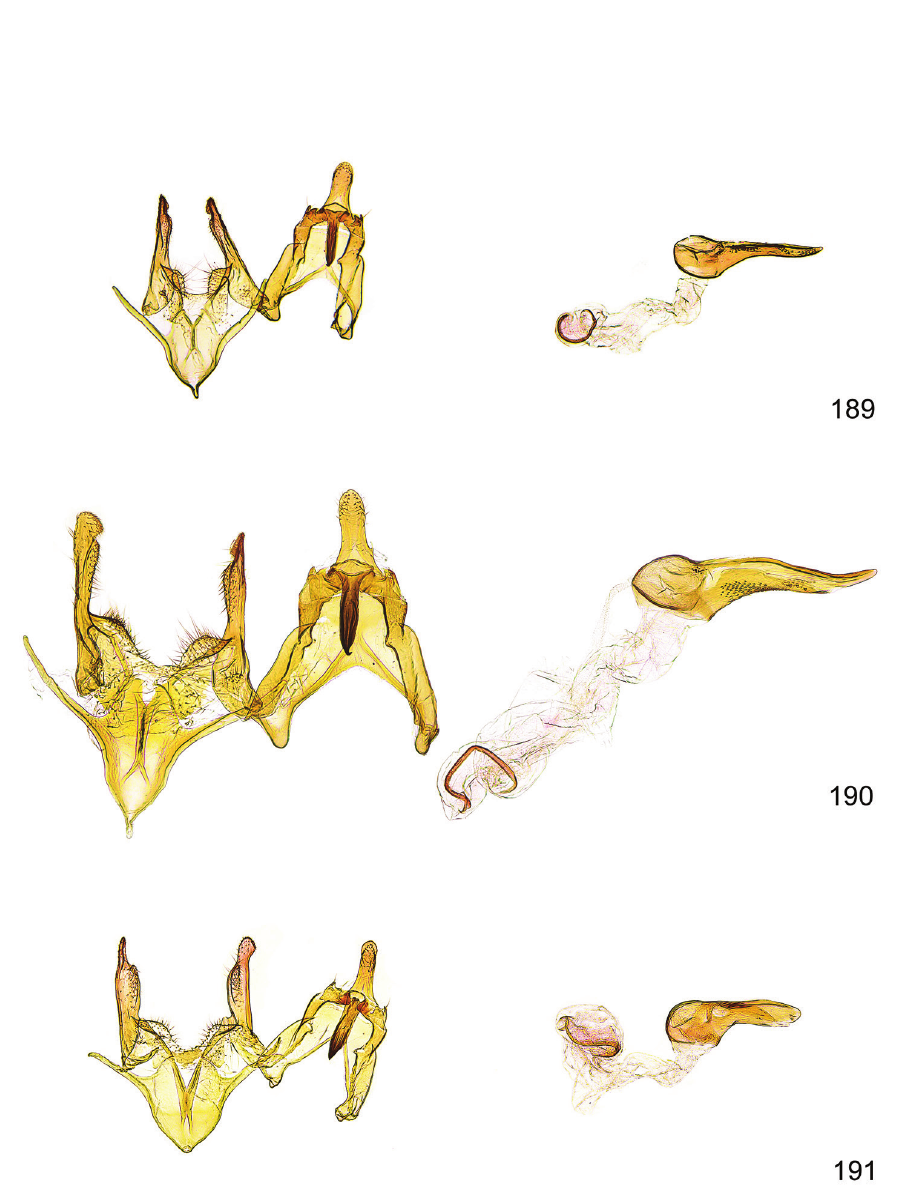
Figures 189–191. Megacraspedus male genitalia. 189 M. spinophallus sp. n. – Holotype, Spain, GEL 1208 P.H. (TLMF) 190 M. spinophallus sp. n. – Paratype, Spain, gen. slide 33659 (BMNH) 191 M. occidentellus sp. n. – Holotype, Portugal, GU 13/1352 P.H.